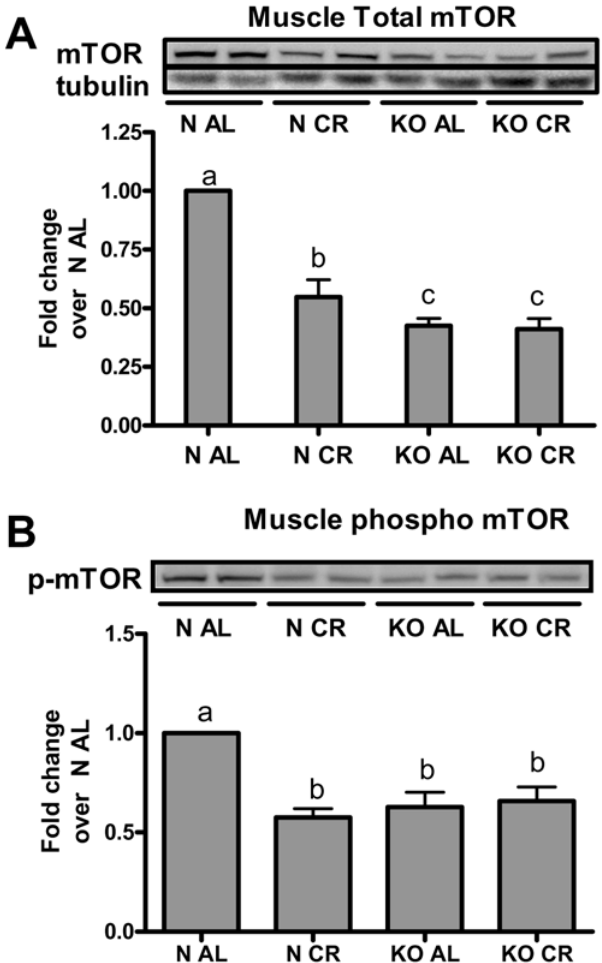
Figure 5. Muscle total IRS-1 protein (A) and IRS-1 pS307 inhibitory phosphorylation (B) in GHRKO (KO) and normal (N) mice fed adlibitum (AL) or 30% calorie restriction (CR) for one year was determined using ELISA. Bars represent 6–8 animals per phenotype/diet group. Values with unlike superscripts/letters are significantly different (P , 0.05).